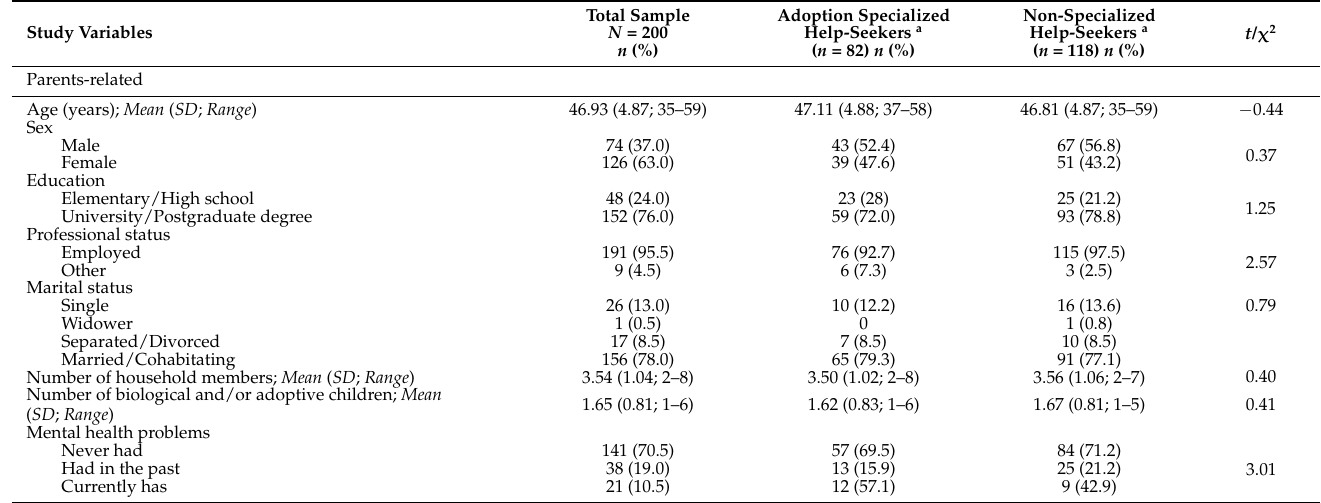
Table 2. Characteristics of Adoptive Parents According to the Type of Help-seeking (Adoption- Specialized vs. Non-Specialized): Descriptive Statistics and Group